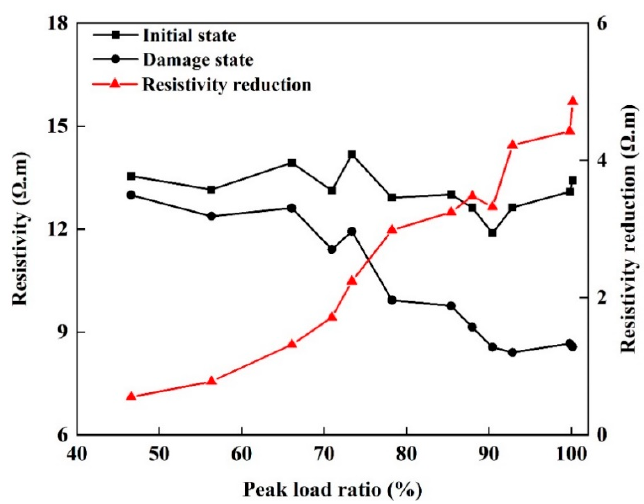
Figure 10. Sandstone resistivity before and after damage under different loading conditions.